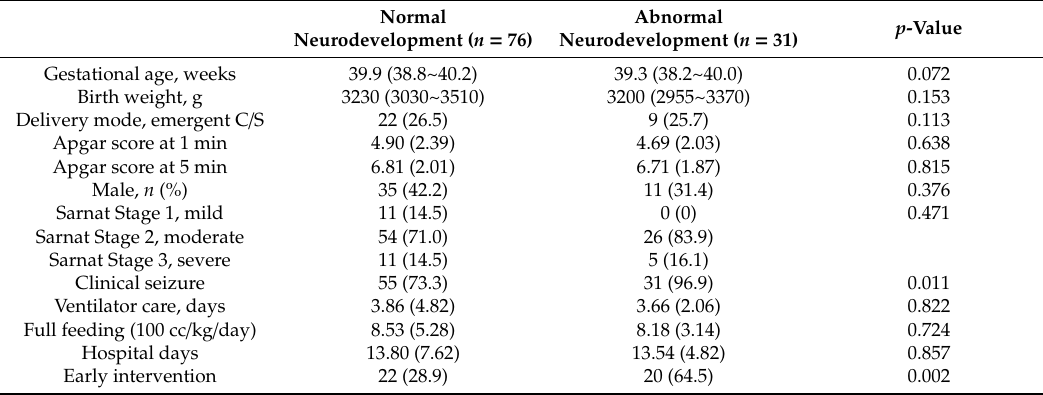
Table 1. Clinical variables related to neurodevelopmental outcomes at corrected 18~24 months of age ( n =